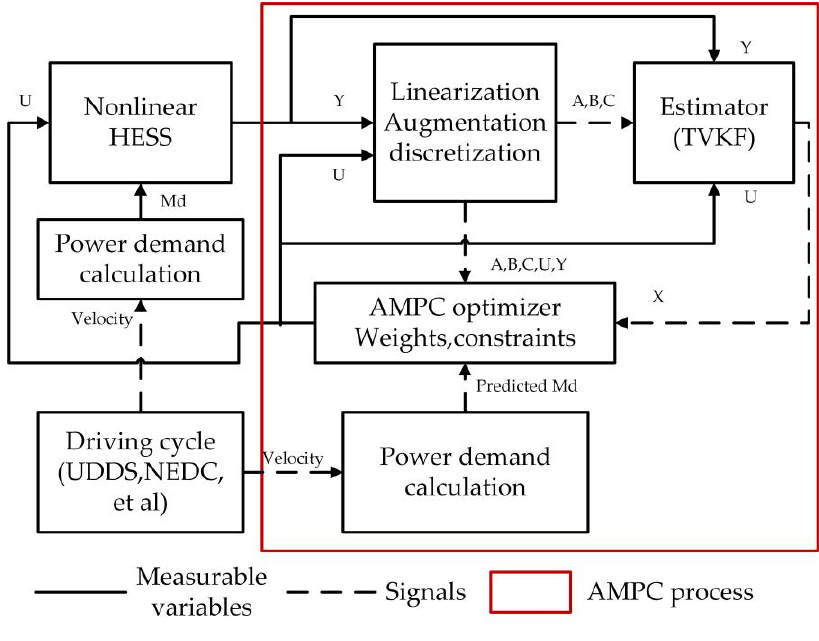
Figure 4. AMPC process.